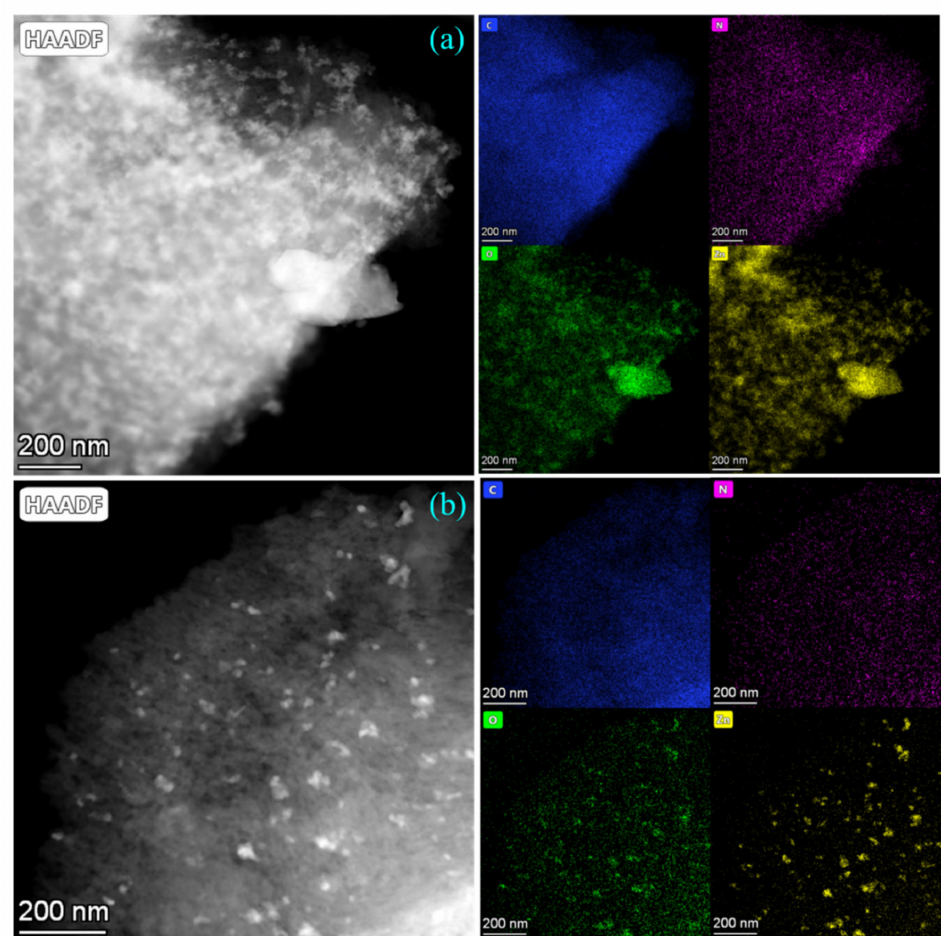
Figure 4. TEM mapping image of the catalyst prepared with water ( a ); TEM mapping image of the catalyst prepared with mixed solvent A ( b ).